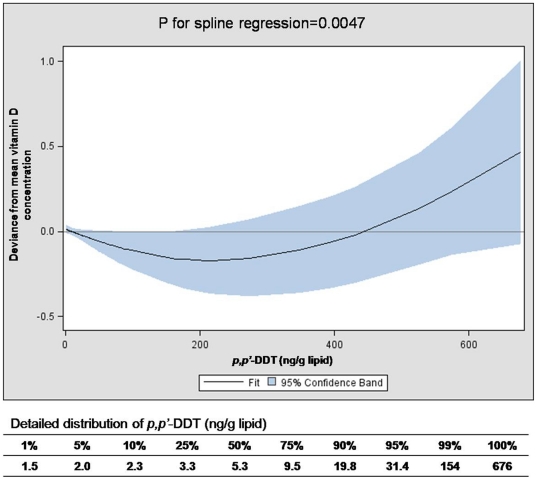
Spline regression of serum concentration of p,p′-DDT on serum 25-hydroxyvitamin D (25(OH)D) levels (ng/ml).The curve was adjusted for gender, age, race, BMI, smoking status, outdoor activity, and vitamin D supplement. The distribution of p,p′-DDT among study subjects was added below the X-axis. The increasing trend of vitamin D was mainly driven by only a very small number of subjects with very high p,p′-DDT.